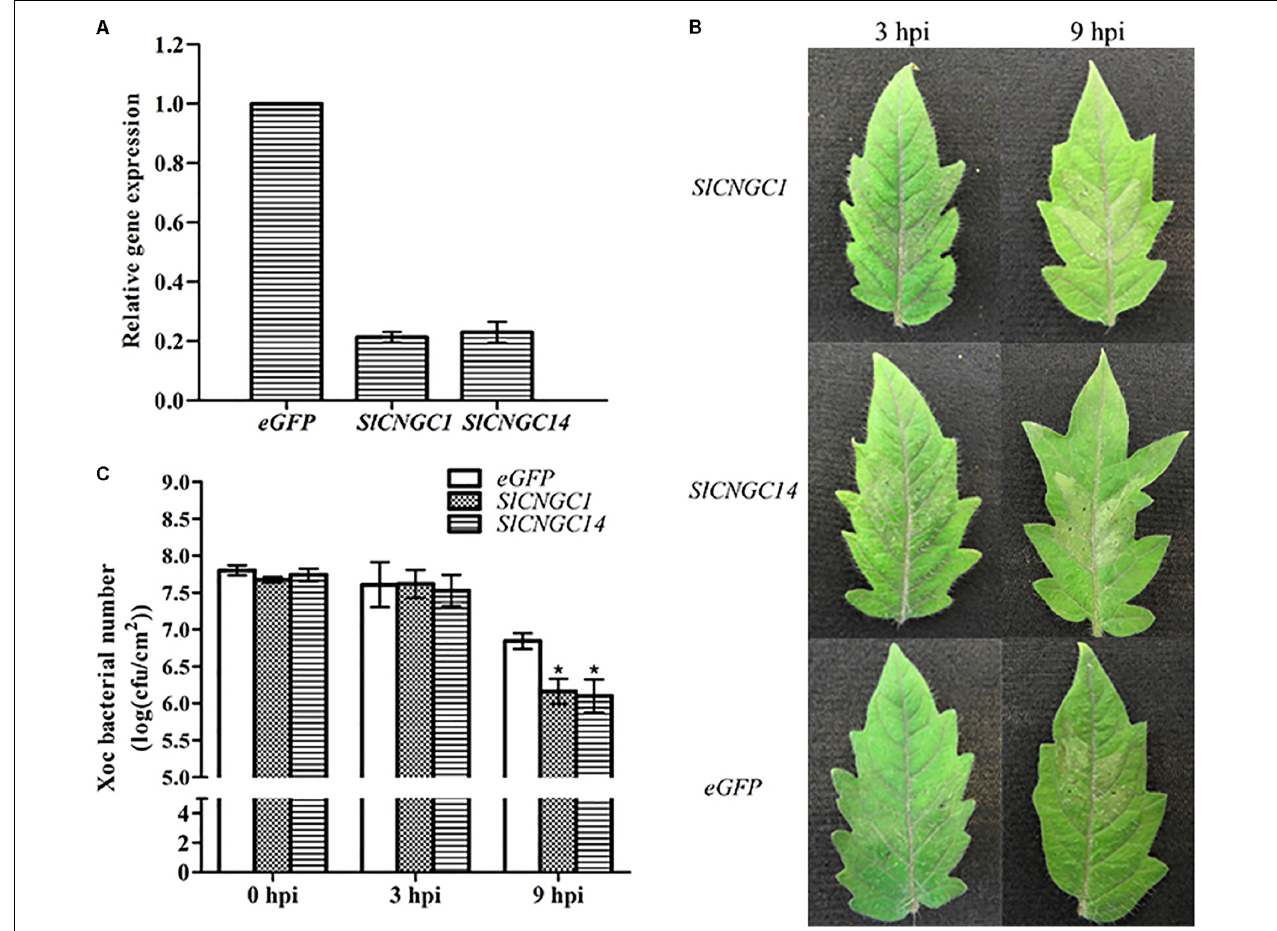
FIGURE 1 | Silencing of SlCNGC1 and SlCNGC14 enhanced HR and non-host resistance to Xoc in tomato. (A) Silencing efficiency analysis. Plants infiltrated with Agrobacterium suspensions carrying an eGFP-control vector served as control plants. Accumulation level of SlCNGC1 and SlCNGC14 transcript in VIGS-treated plants and the eGFP-control plants was detected by qRT-PCR analyses. (B) Xoc -induced hypersensitive response (HR). Photographs were taken at 3 and 9 hpi. (C) Xoc bacterial number counting. Xoc bacterial numbers were counted in leaf areas that were inoculated with bacterium at 3 and 9 hpi. At least five leaves were tested for each treatment, and the data represent means ± standard error (SE). Significant differences between treatments and the control are indicated by an asterisk ( p <